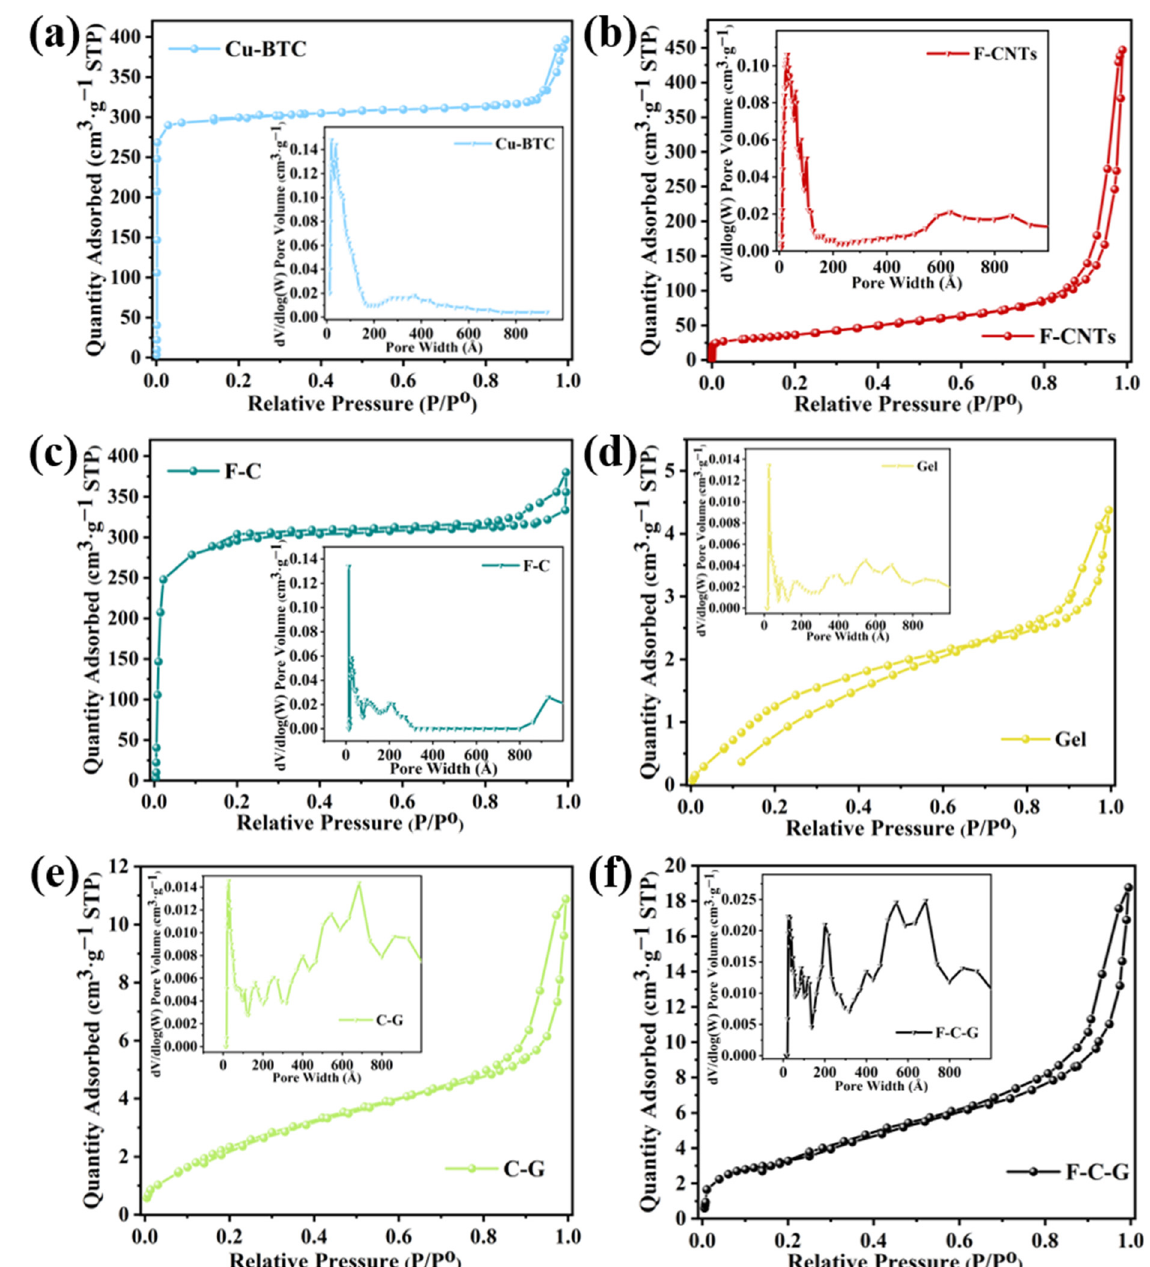
Figure 2. N 2 adsorption–desorption isotherms and pore size distributions (see insets) of different materials: ( a ) Cu-BTC, ( b ) F-CNTs, ( c ) F-C, ( d ) Gel, ( e ) C-G, ( f ) F-C-G. materials: ( a ) Cu-BTC, ( b ) F-CNTs, ( c ) F-C, ( d ) Gel, ( e ) C-G, ( f )